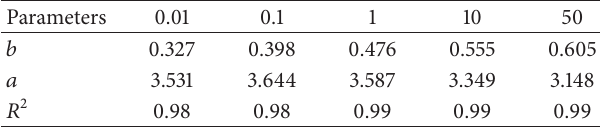
Table 7: Fitting parameters of the GSC model at different frequen- cies.